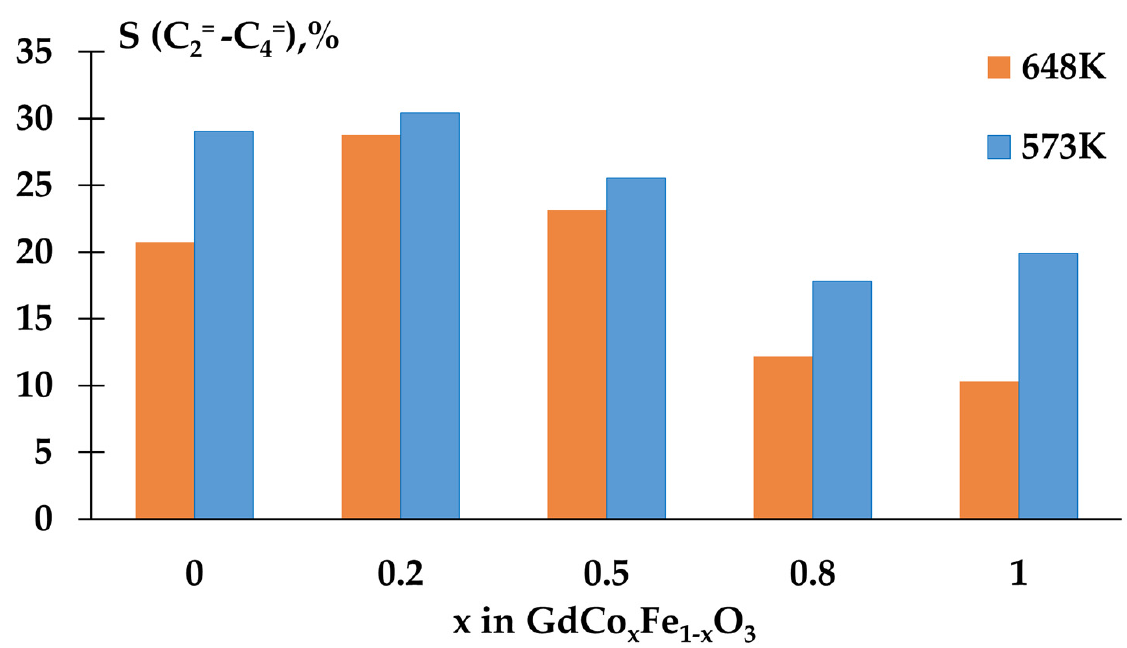
Figure 9 . Temperature dependences of selectivity for light olefins over GdCo x Fe 1-x O 3 catalysts. Figure 9. Temperature dependences of selectivity for light olefins over GdCo x Fe 1 − x O 3 catalysts. To determine kinetic characteristics, such as the effective activation energies of product formation and the logarithms of the pre-exponential multiplier (an indirect characteristic of the number of the active centers of the catalyst surface), the interpolation of experimental data in linear coordinates of the Arrhenius equation was performed. On the Arrhenius dependences of the rates of formation of ethylene for samples with a content of cobalt x > 0.5 two areas of linearity with a transition temperature of about T* ≈ 598–609.7 K were observed. The presence of two linear sections with different values of the activation energies E a indicates either a change in the state of the active Me n+ centers depending on the temperature (change in the oxidation state of Co 3+ ↔ Co 2+ ) or the course of different processes of a complex reaction in each temperature interval (T < T* is chemisorption of reactants, and T > T* is the conversion of chemisorbed complexes into products). The calculated values of the effective activation energies for the formation of reaction products and the logarithms of the prefactor for all the catalysts studied are shown in Table 3.